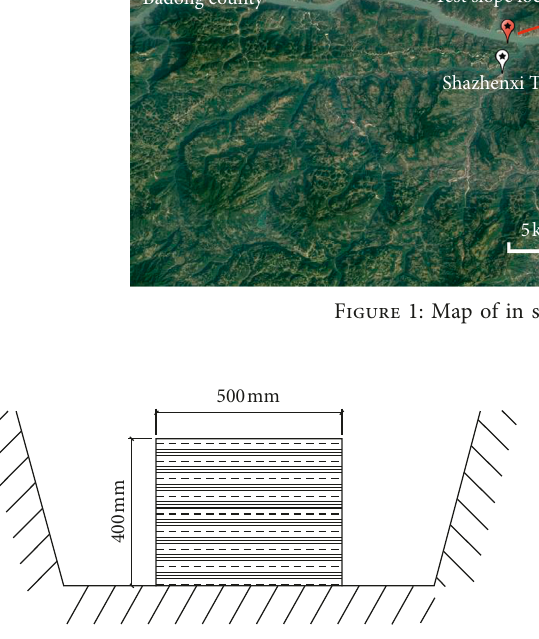
Figure 2: In situ direct shear samples preparation.